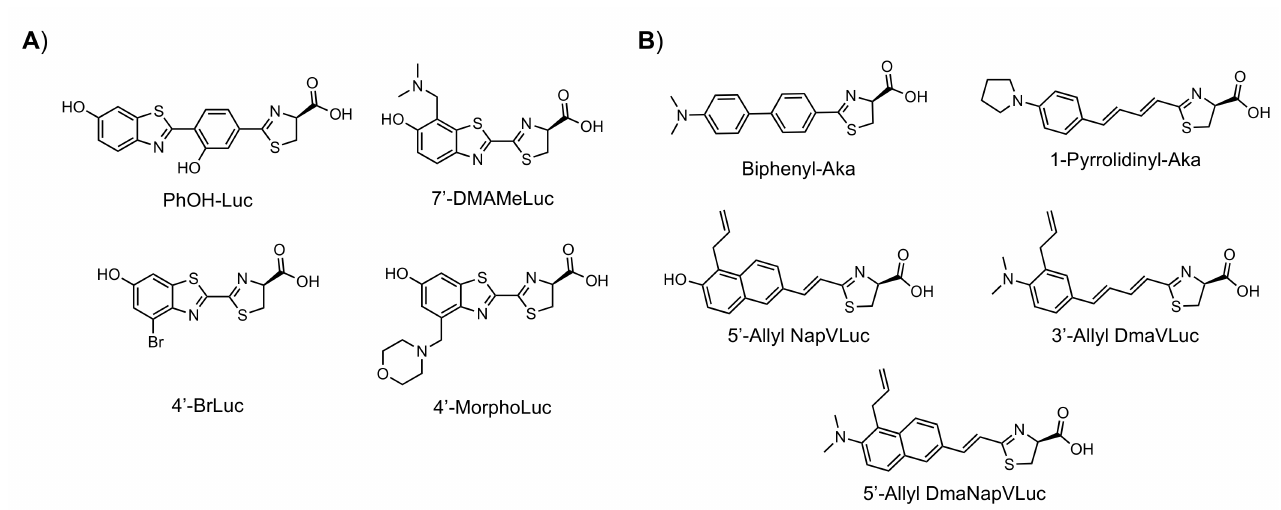
Figure 1. The structures of several artificial bioluminescence substrates ( A ) and weak-intensity luciferin analogues ( B